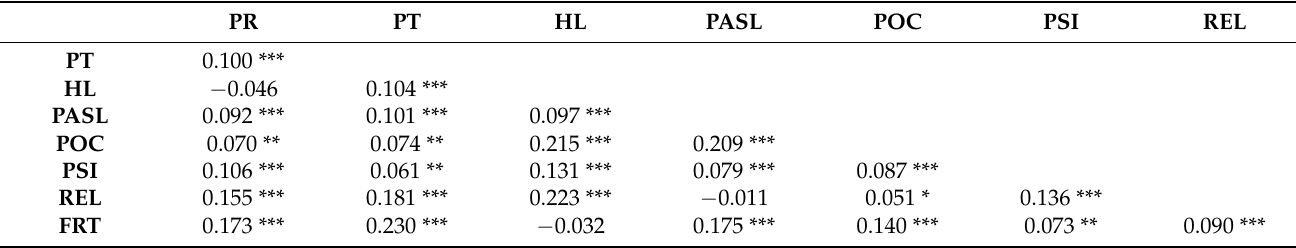
Table 4. Correlation matrix of